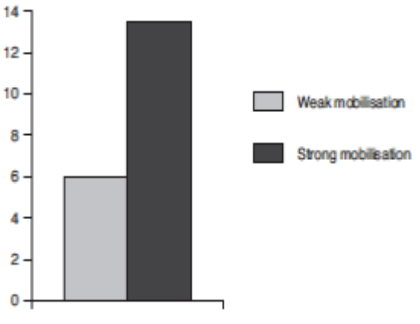
Graf. 3 - Connections by six LHCs located in areas with different histories of